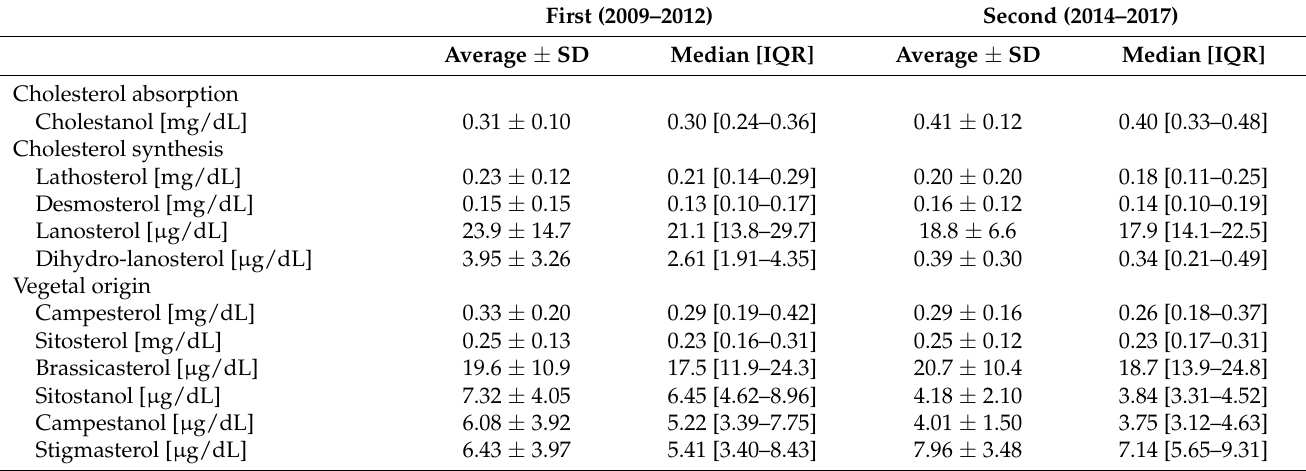
Table 2. Serum sterol concentrations and sterol ratios, first (2009–2012) and second (2014–2017) follow-up, CoLaus|PsyCoLaus study, Lausanne,